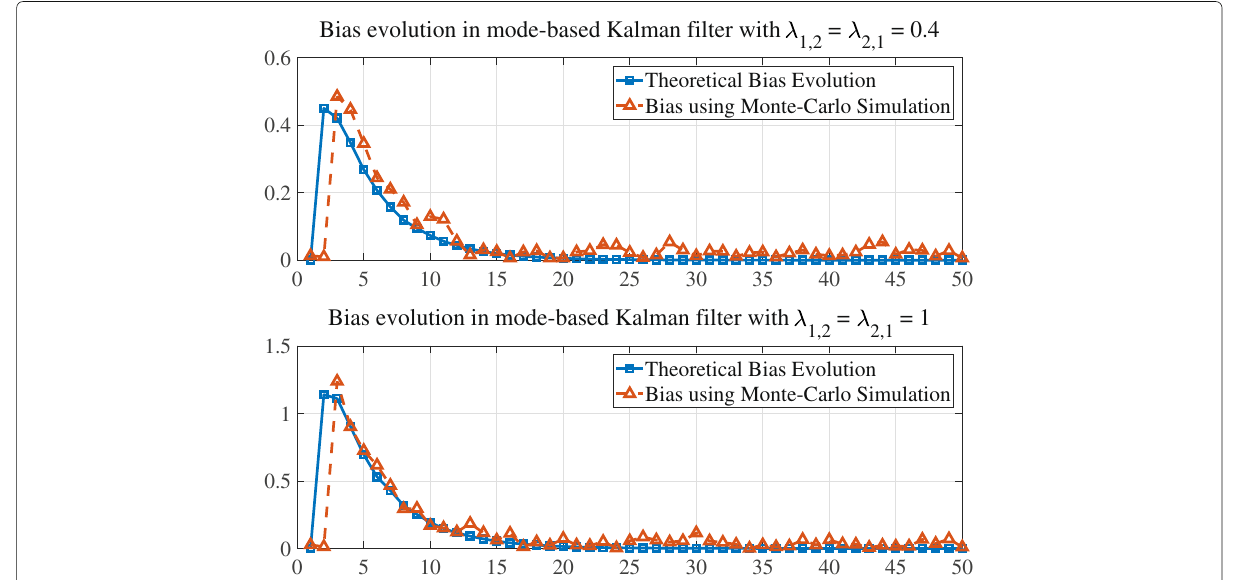
Fig. 3 Bias in mode-based Kalman filter using Monte-Carlo simulation and theoretical bias evolution for switching signal 1